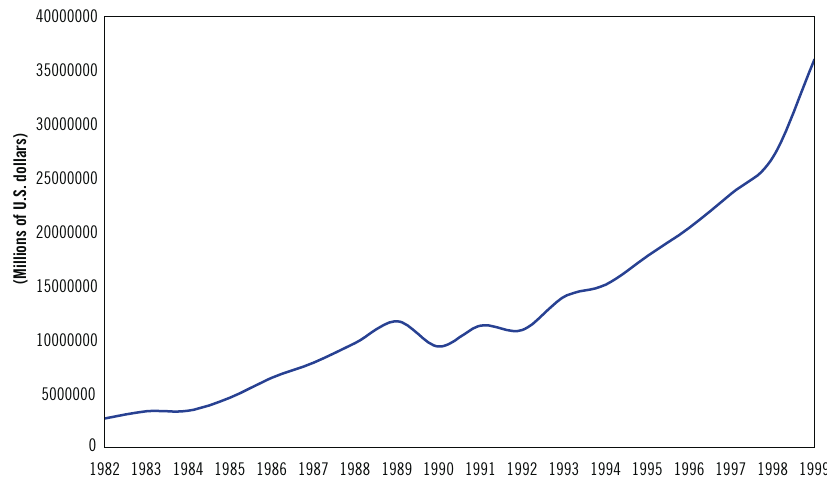
Figure 3 – Market Capitalization: World Stock Markets, 1982–1999 Figure 4 – New York’s Primacy in the 1990s: Equity